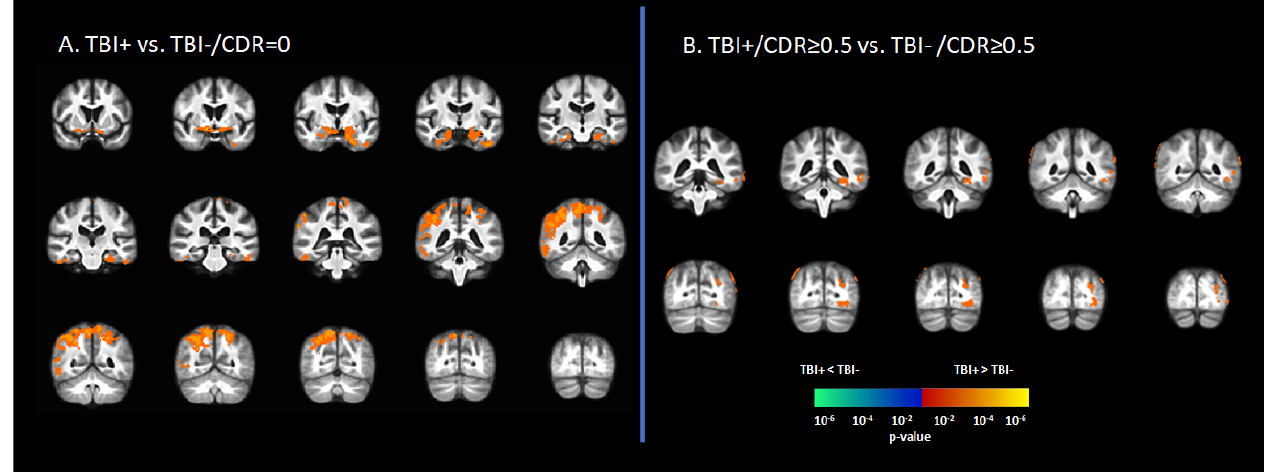
0.01 ** TBI+, participants with self-reported traumatic brain injury; TBI − ,participants without self-reported